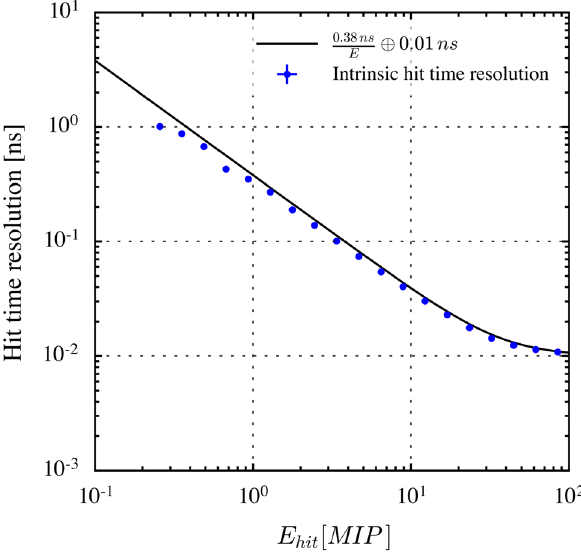
Fig. 6 The intrinsic hit time resolution as a function of the energy deposition in the silicon sensors. The black solid line is the model of CMS measurement [1] and the blue dots are the result of the digitization in the 10 GeV μ −